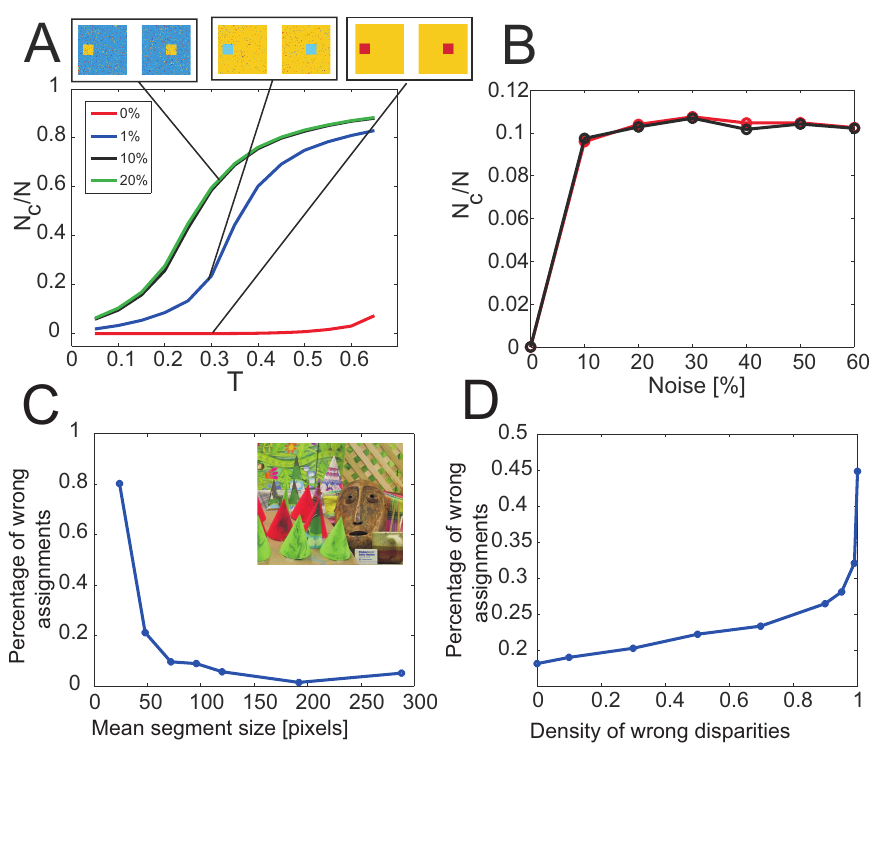
divided by the c /N c